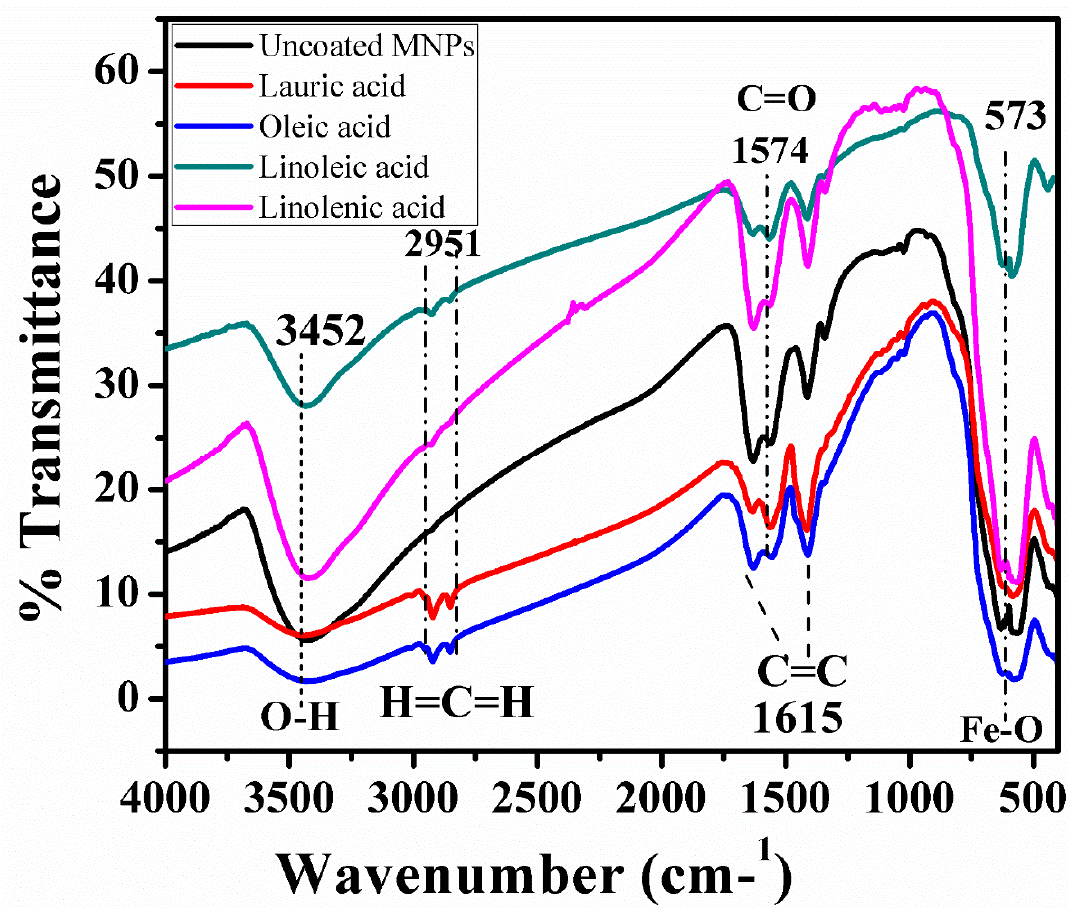
Figure 2. TIR spectra of uncoated and surfactant-coated MNPs.